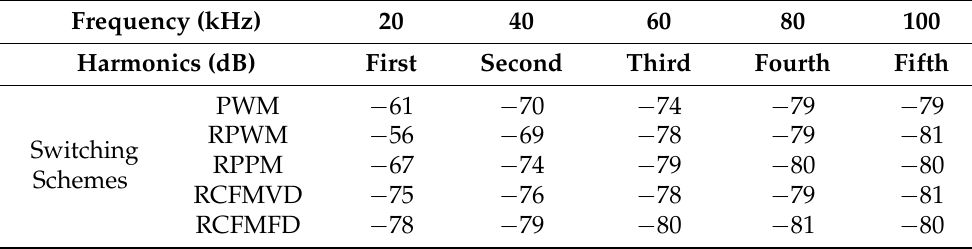
Figure 8. Comparison result for an interleaved buck converter for different modulation schemes: ( a ) switching current harmonics and ( b ) switching current harmonics up to the fifth harmonic. Table 3. Comparison of current harmonics for an interleaved buck converter (harmonics values are in dB).